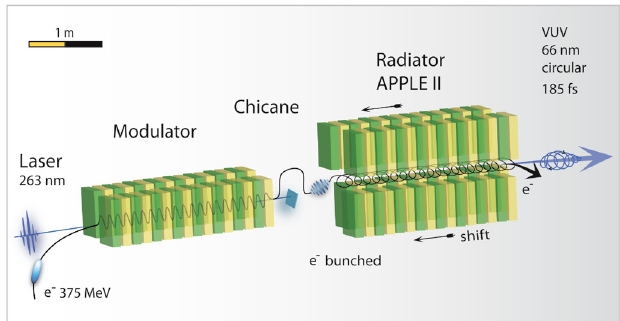
FIG. 1. Principle of the experimental setup of the MAX-lab test FEL (undulator section). Seeding occurs at 263 nm in the modulator which applies a horizontal field to the electron beam. After bunching in a dispersive section (chicane), the radiator emits circularly polarized coherent pulses up to the 4th harmonic at 66